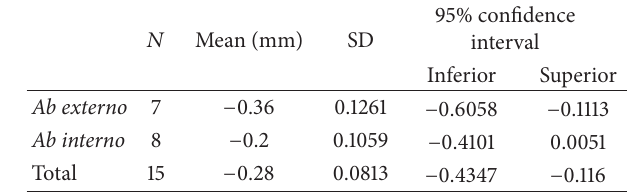
Table 3: Intraocular lens position in relation to the iris (IOL tilt) in the vertical plane (12 and 6 h), considering UBM